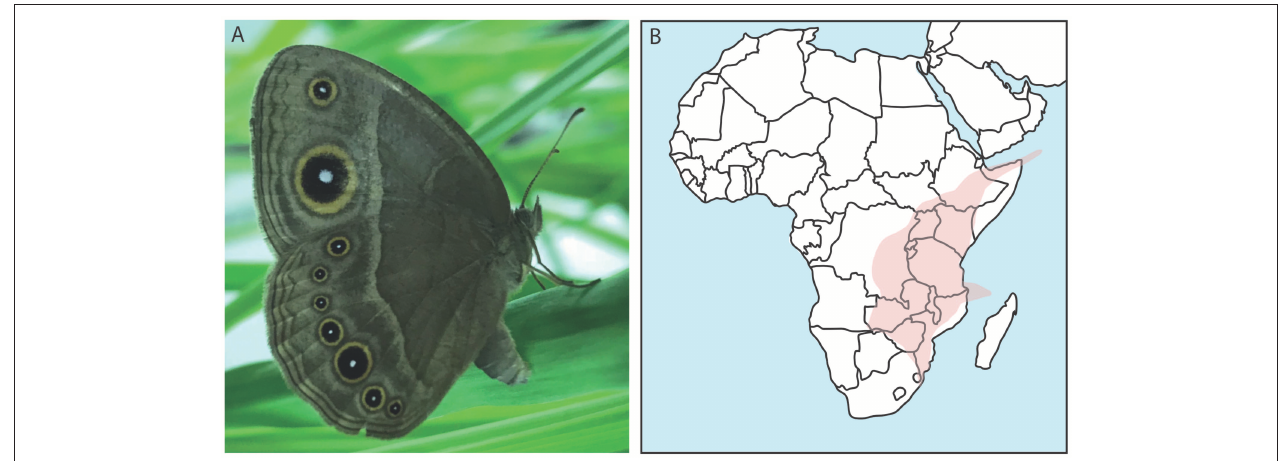
FIGURE 1 | The African butterfly Bicyclus anynana and its distribution. (A) Shown is a female specimen of B. anynana with the characteristic eyespots on its wings. (B) Confirmed findings of B. anynana in Southeast Africa in the area indicated. This species can be found in: Democratic Republic of Congo, Kenya, Rwanda, Burundi, Tanzania, Uganda, Zambia, Malawi, Mozambique, Socotra islands, Comoro islands, and South Africa ( Otto, 2015; Brattström et al.,